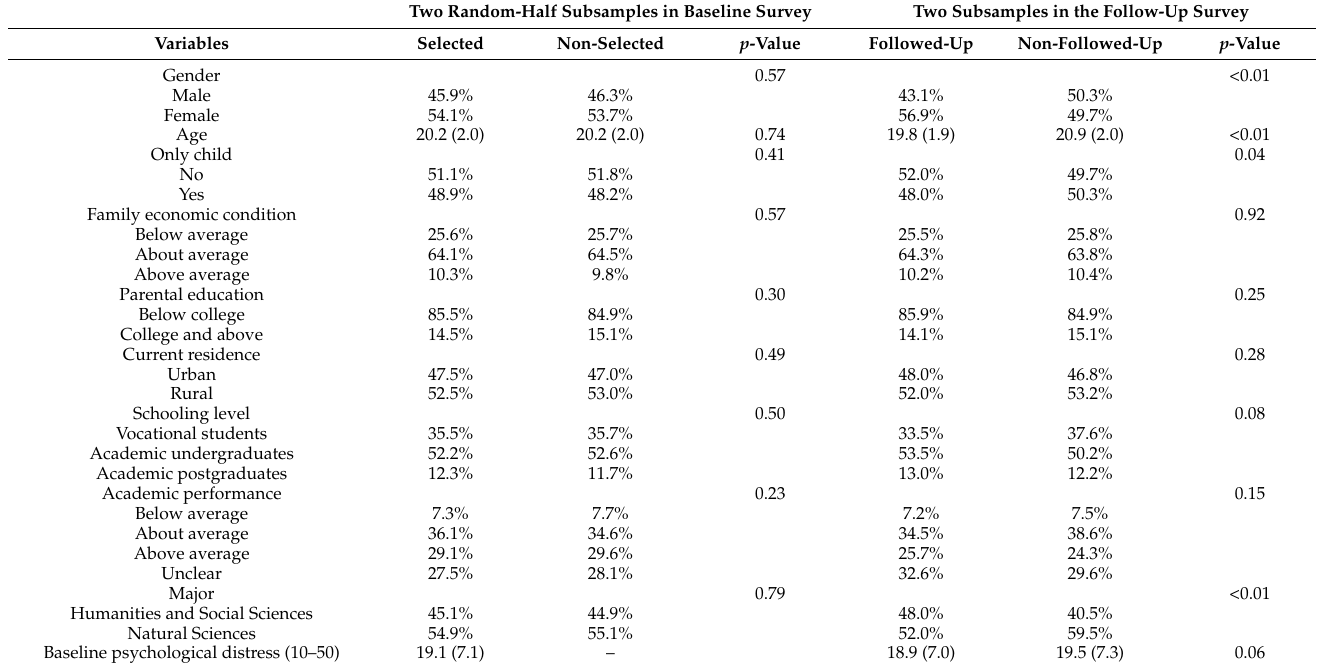
Table A1. Comparison of descriptive statistics between the baseline random-half sample and the other half and between the followed-up sample and the non-followed-up sample.